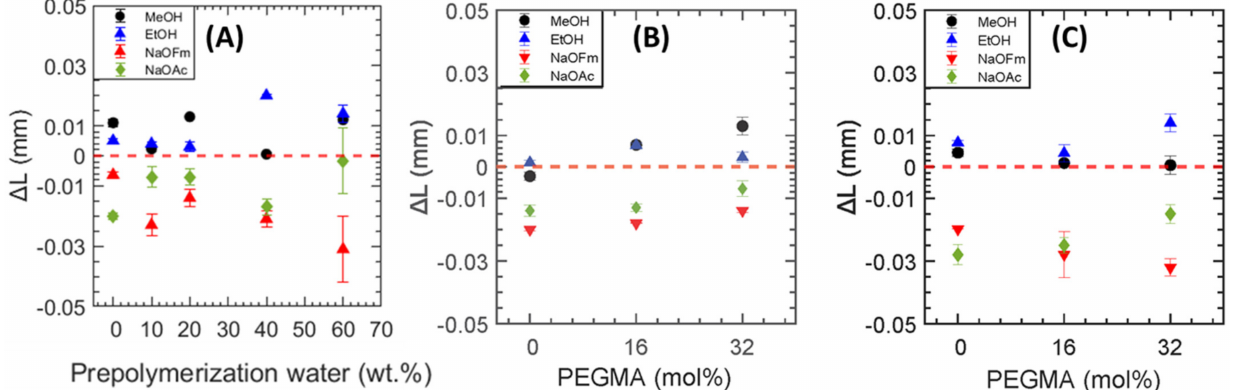
Figure 6. Dimensional Swelling as membrane thickness ( ∆ L , mm) as a function of ( A ) pre − polymerization water wt% at 32 mol% PEGMA, ( B ) varying PEGMA content at 20 wt% pre − polymerization water content, and ( C ) varying PEGMA content at 60 wt% pre − polymerization water content PEGDA based